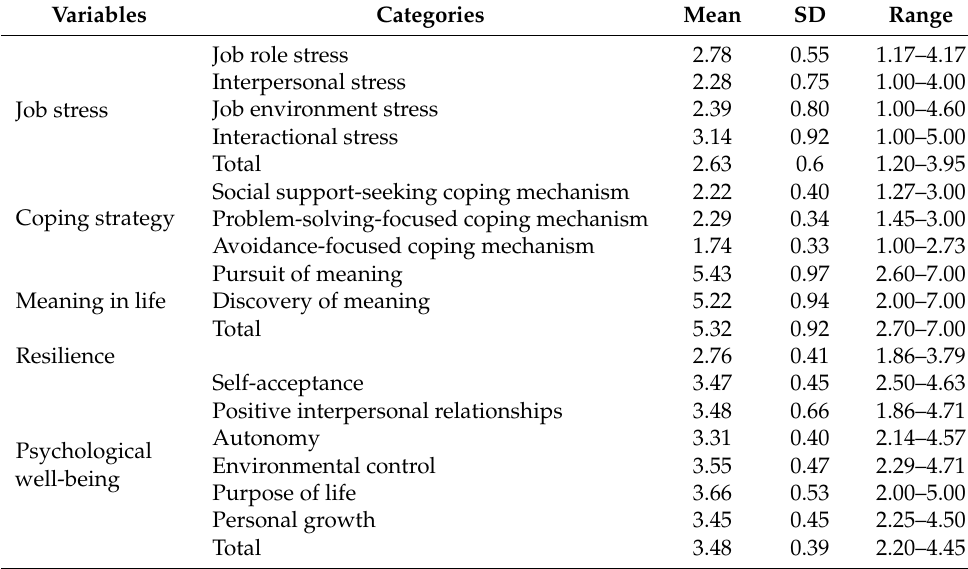
Table 2. The degree of the research variables (N =